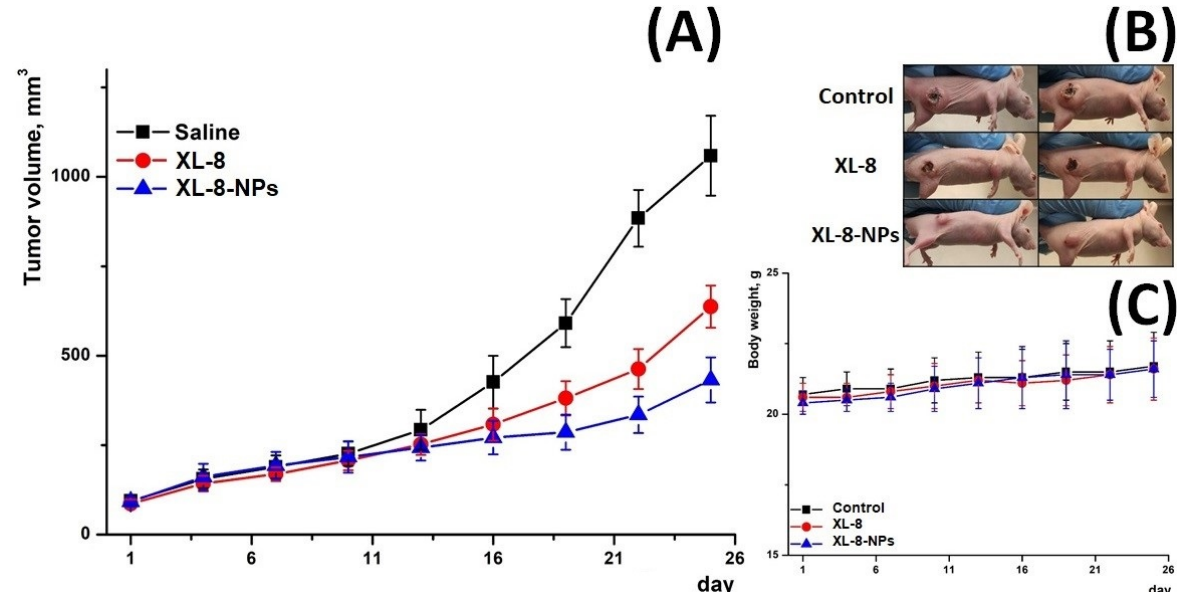
Figure 7. Tumor growth inhibition after treatment ( A ). Representative photo of treated tumor ‐ bearing mice taken on day 25 ( B ). Body weight changes of tumor ‐ bearing mice over the treatment period ( C ) ( n = 3).